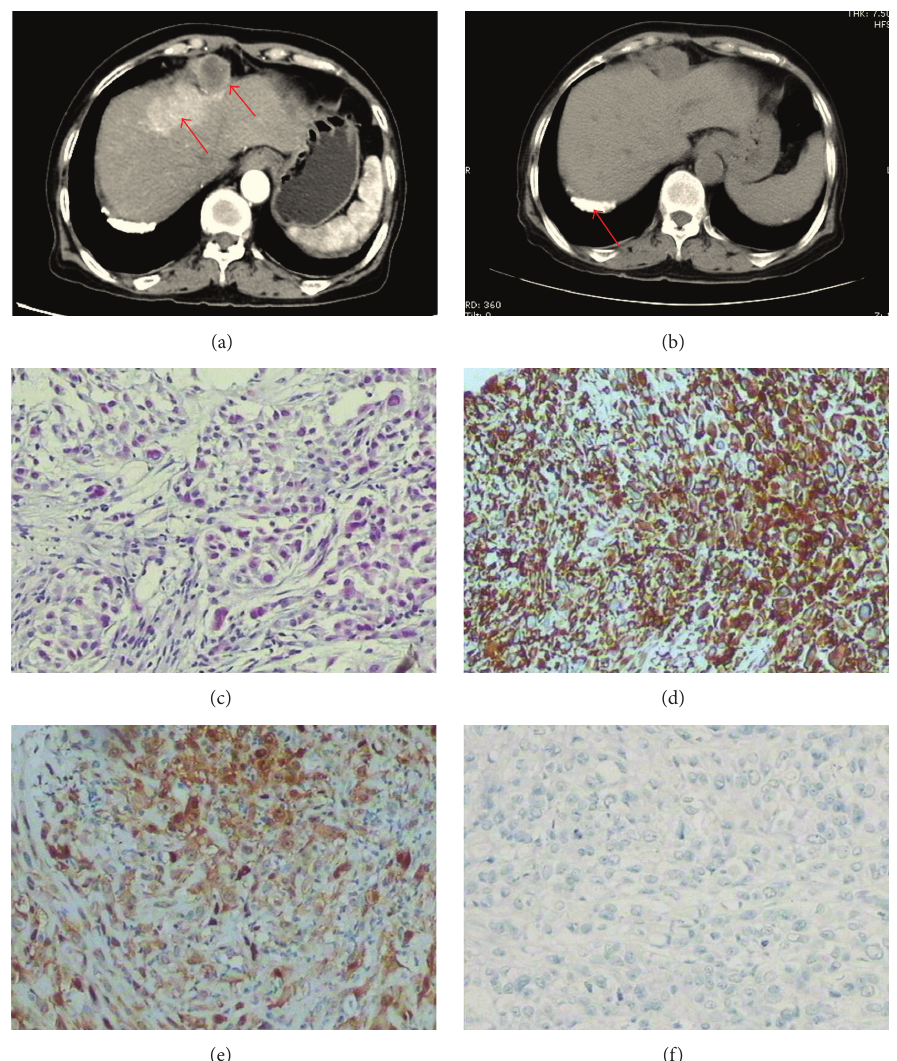
Figure 2: Abdominal CT and cytohistological features on H&E-stained specimens or immunohistochemical stains for case 2. (a) Abdominal CT demonstrated hepatic nodule in the VI segment of the right lobe of the liver and there were nodules in the soft tissue anterior to the liver (redarrows).(b)AbdominalCTdemonstratedpleuralplaque(redarrows).(c)Cytohistologicalfeaturesofthenodulesbiopsyinthesofttissue anterior to the liver on H&E-stained specimens. Immunohistochemical stains showed that the tumour cells were positive for mesothelial cell antibody (d) and calretinin (e) but negative for carcinoembryonic antigen